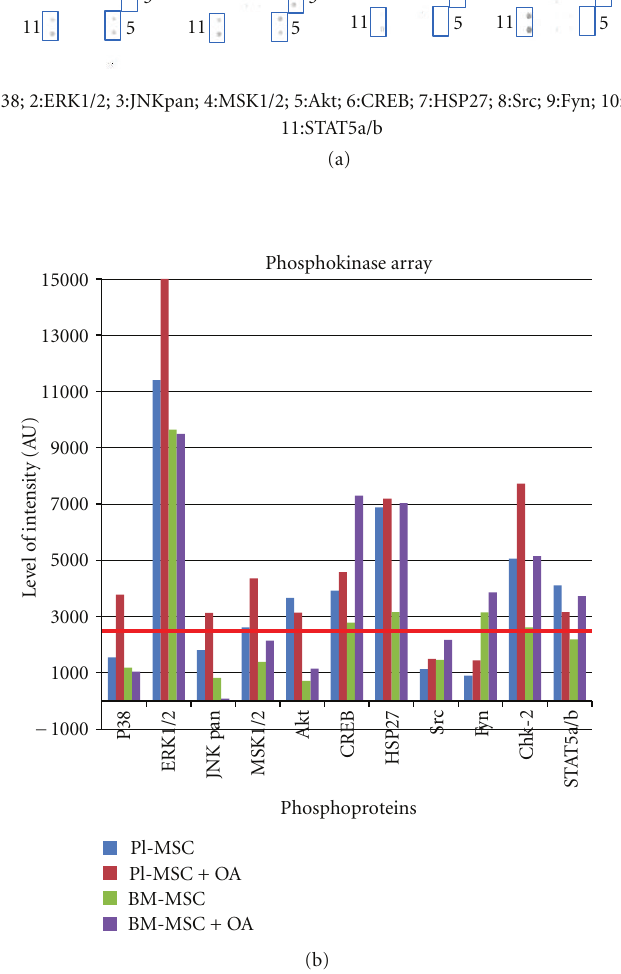
Figure 6: Phosphokinase array analysis 4 h after osteoactivin stimulation. After 4h of OA stimulation, cells were harvested and protein extracts analyzed with the human Phosphokinase array from R&D system. (a) Phosphokinase profile in Pl-MSCs and BM-MSCs using the proteome profiler. (b) Quantification of phosphokinase optical density. Measurements were obtained with image J software (NIH). ERK2 is activated in placental MSCs when submitted to osteoactivin